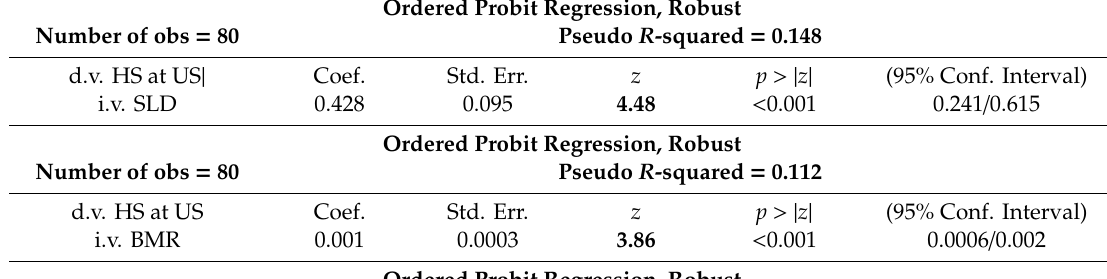
Table 8. Prediction of hepatic steatosis (HS) at US by SLD, BMR, IL-16 and IL-12p40. Ordered Probit Regression, Robust